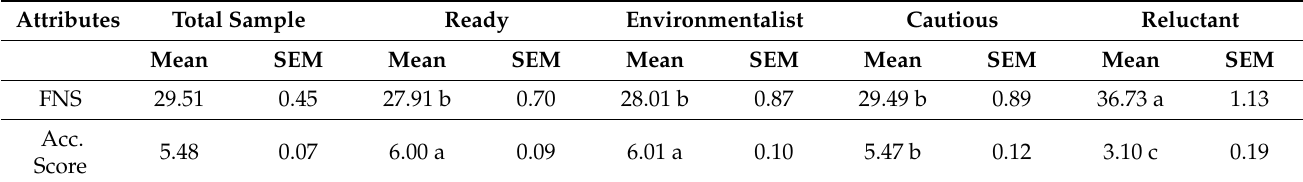
Table 4. Neophobia mean score (FNS) and acceptance mean score calculated for total population and consumer clusters.